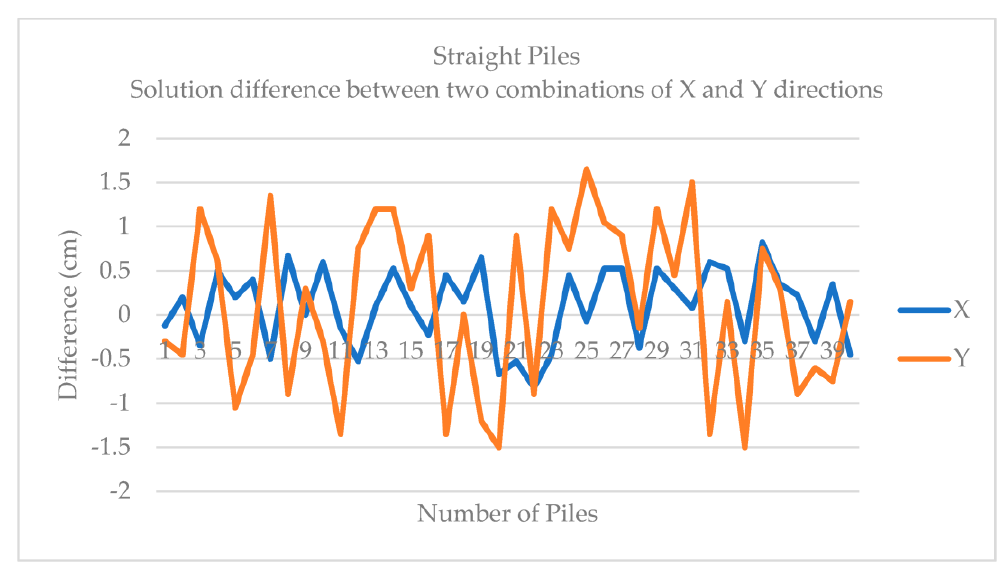
ff erence between two combinations in X and Y directions for straight Figure 15. Solution difference between two combinations in X and Y directions for straight piles. Figure 15. Solution di